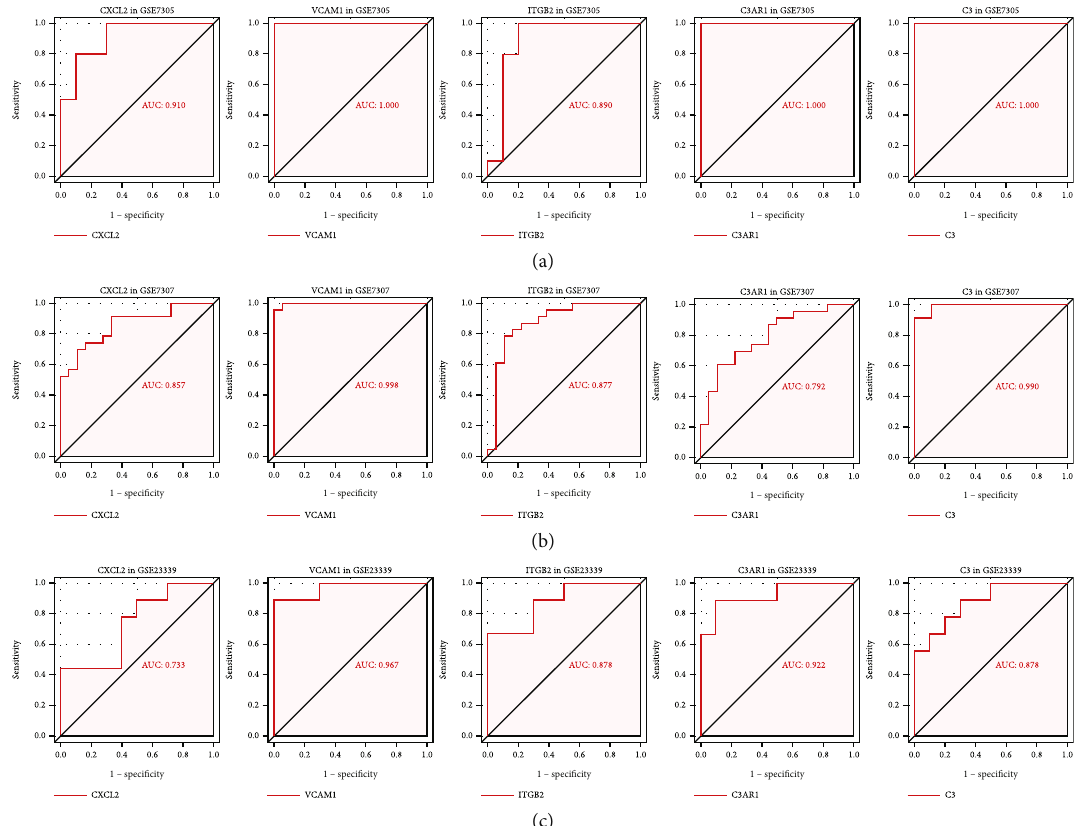
Figure 15: The ROC analysis of the hub IRGs predicting the onset of endometriosis. (a) GSE7305 dataset. (b) GSE7307 dataset. (c) GSE23339